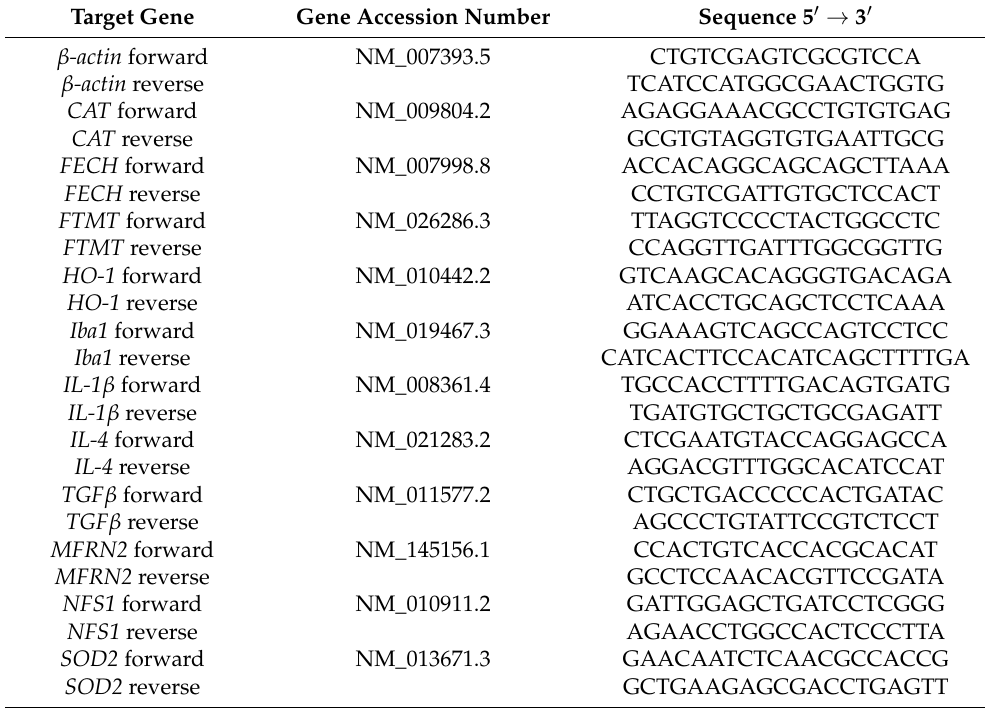
Table 1. Real-time PCR gene primer sequence